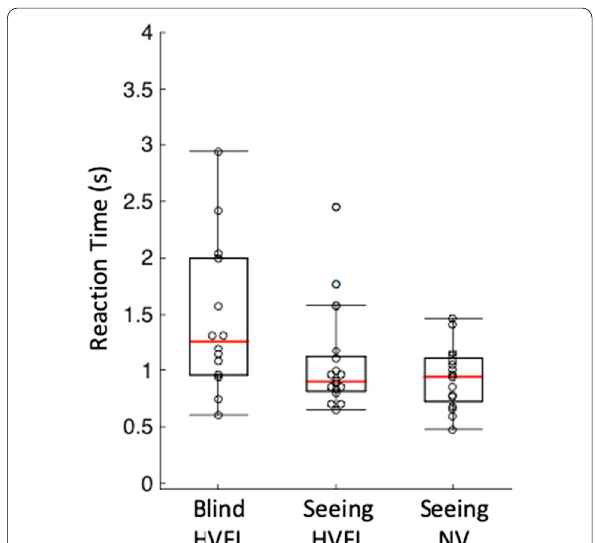
Fig. 6 Boxplots of the median reaction time across participants for detections of the changes that appeared in the blind hemifield and seeing hemifield in those with HVFL and in those with NV. Individual markers (open circles) in the figure correspond to median RT for each